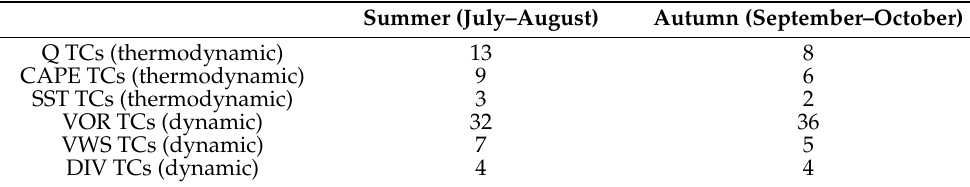
Figure 10. Proportions of TCs affected predominantly by thermodynamic and dynamic factors dur- ing summer (July–August) and autumn (September–October). The estimation was based on the sta- tistical results of WU20, which are also listed in Table 1. results of WU20, which are also listed in Table 1. Table 1. Numbers of TCs affected predominantly by different factors 1 . Table 1. Numbers of TCs affected predominantly by different factors 1